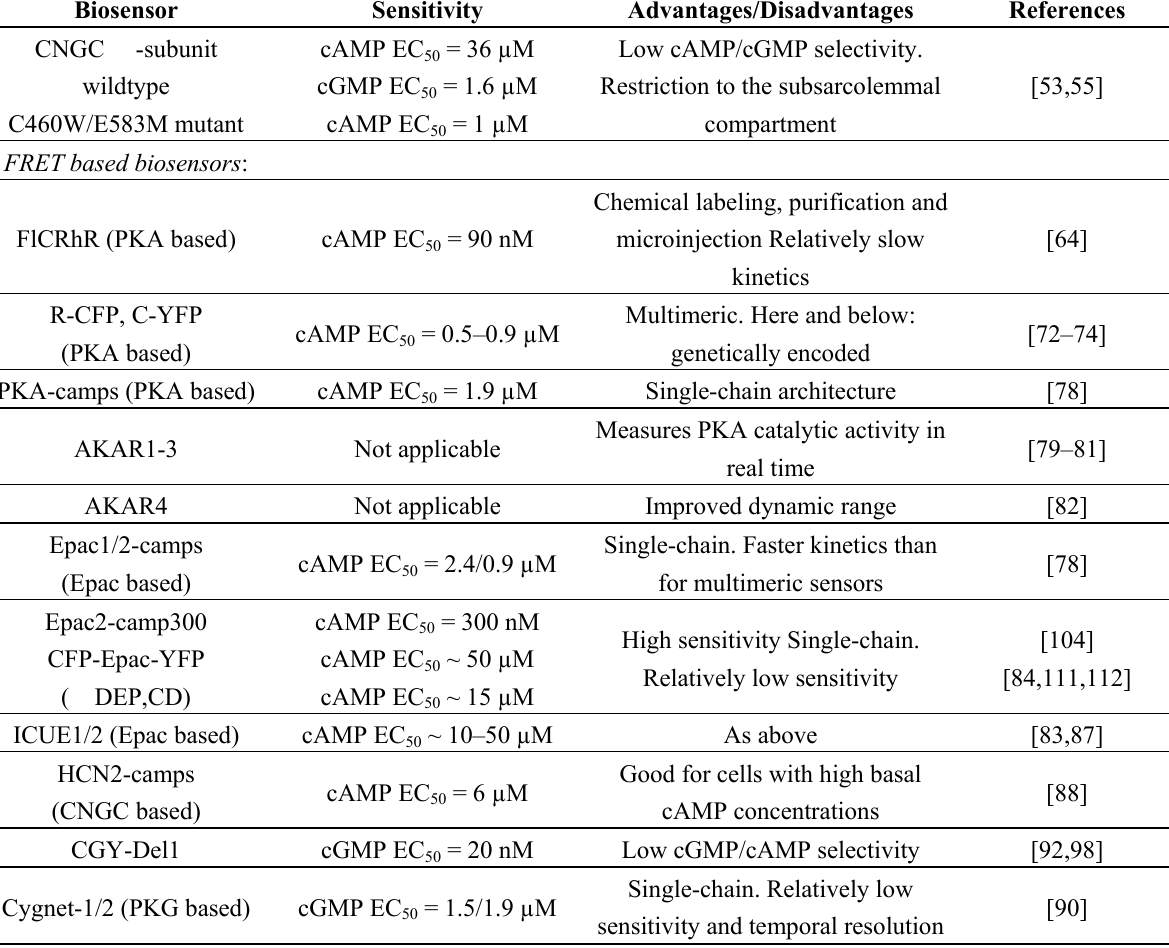
Table 1. Currently available Förster Resonance Energy Transfer (FRET) biosensors for cAMP, cGMP, and PKA